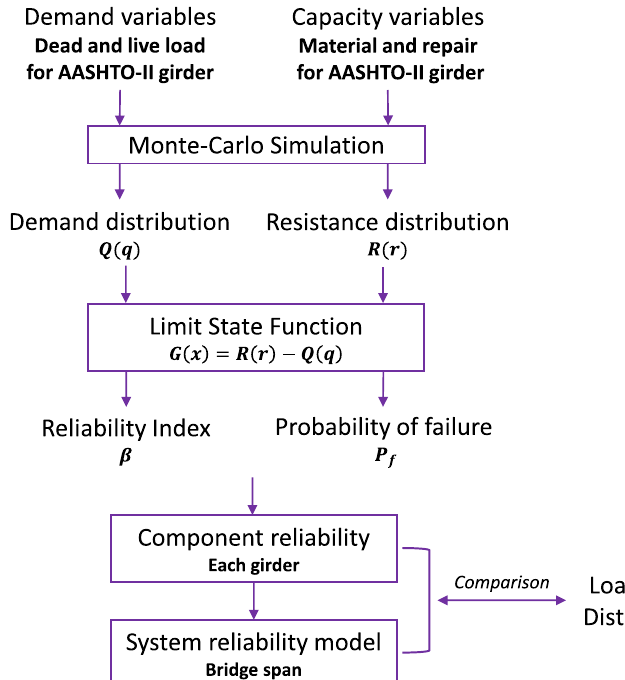
Fig. 1 The scope of the